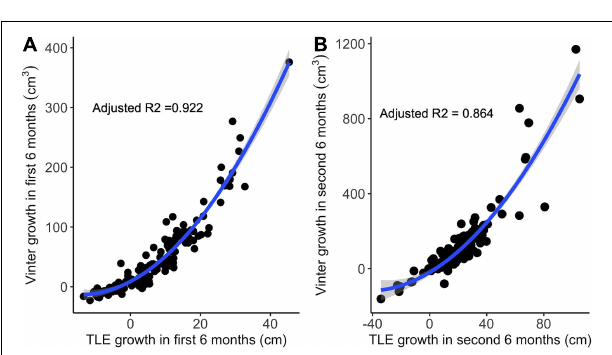
FIGURE 3 | Growth in TLE compared to growth in V inter over the first 6 months (A) and over the second 6 months (B) . The solid blue line shows the second order polynomial fit to each relationship. Shaded areas around each line represent the 95% confidence intervals ( n =